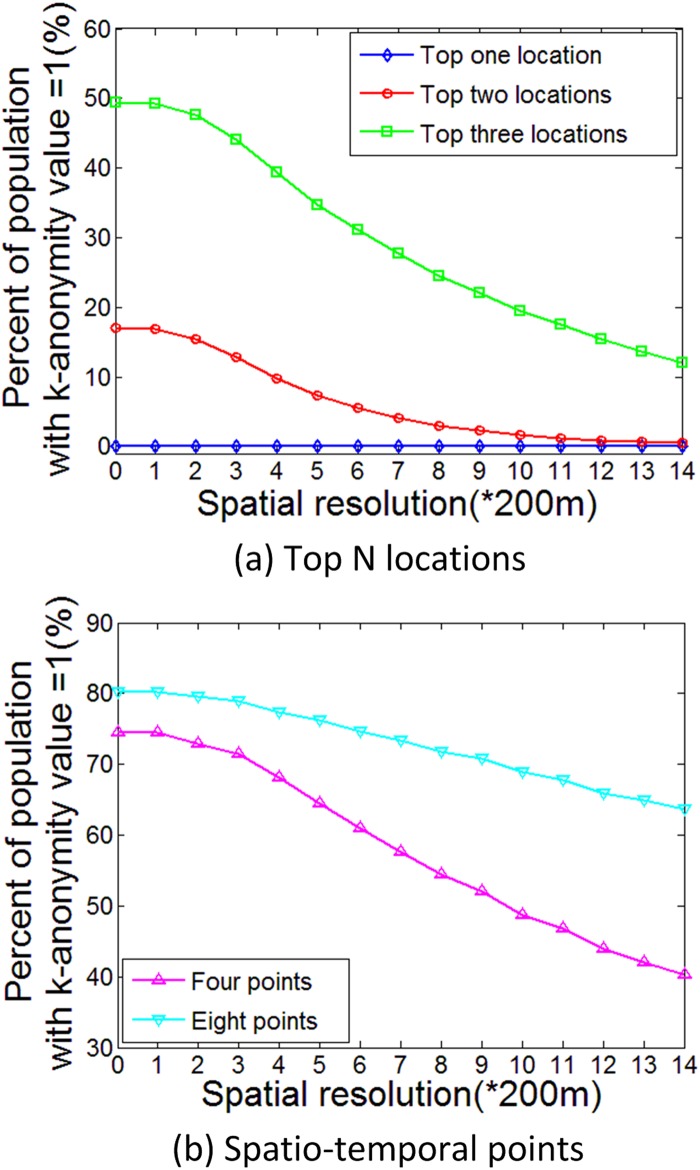
Privacy risk reduction of two privacy models.(a) Top N locations. (b) Spatio-temporal points.